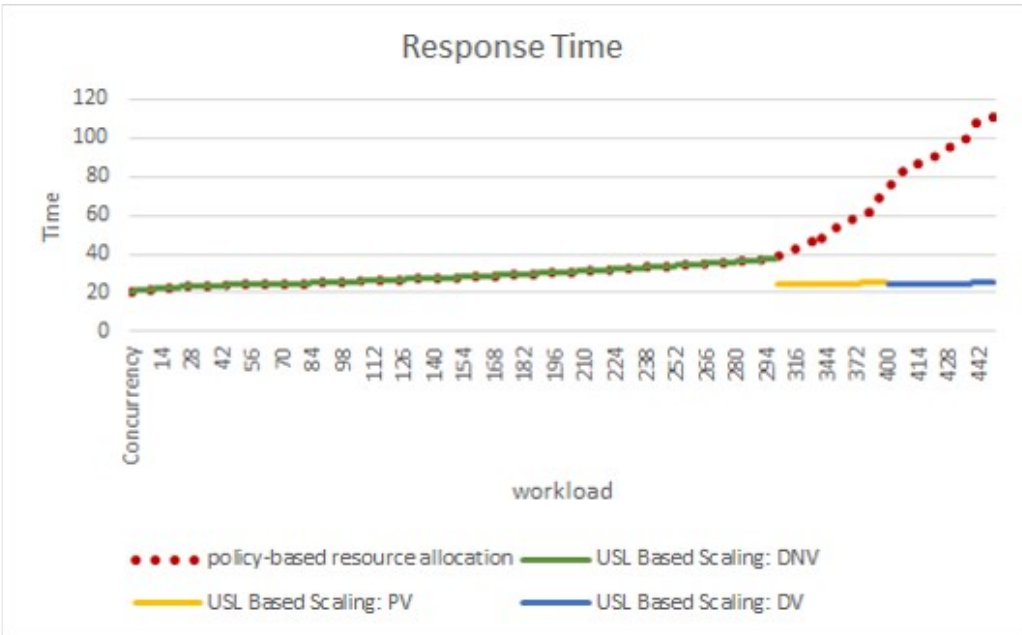
Figure 6. QoS satisfied Response